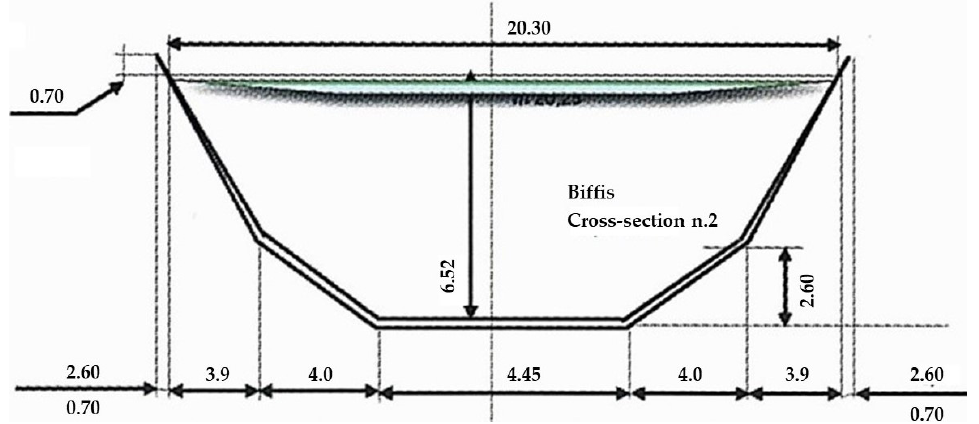
Figure 2. Cross-section of interest in the Biffis canal from Malini [25], which was modified according to the design specifications of this work.